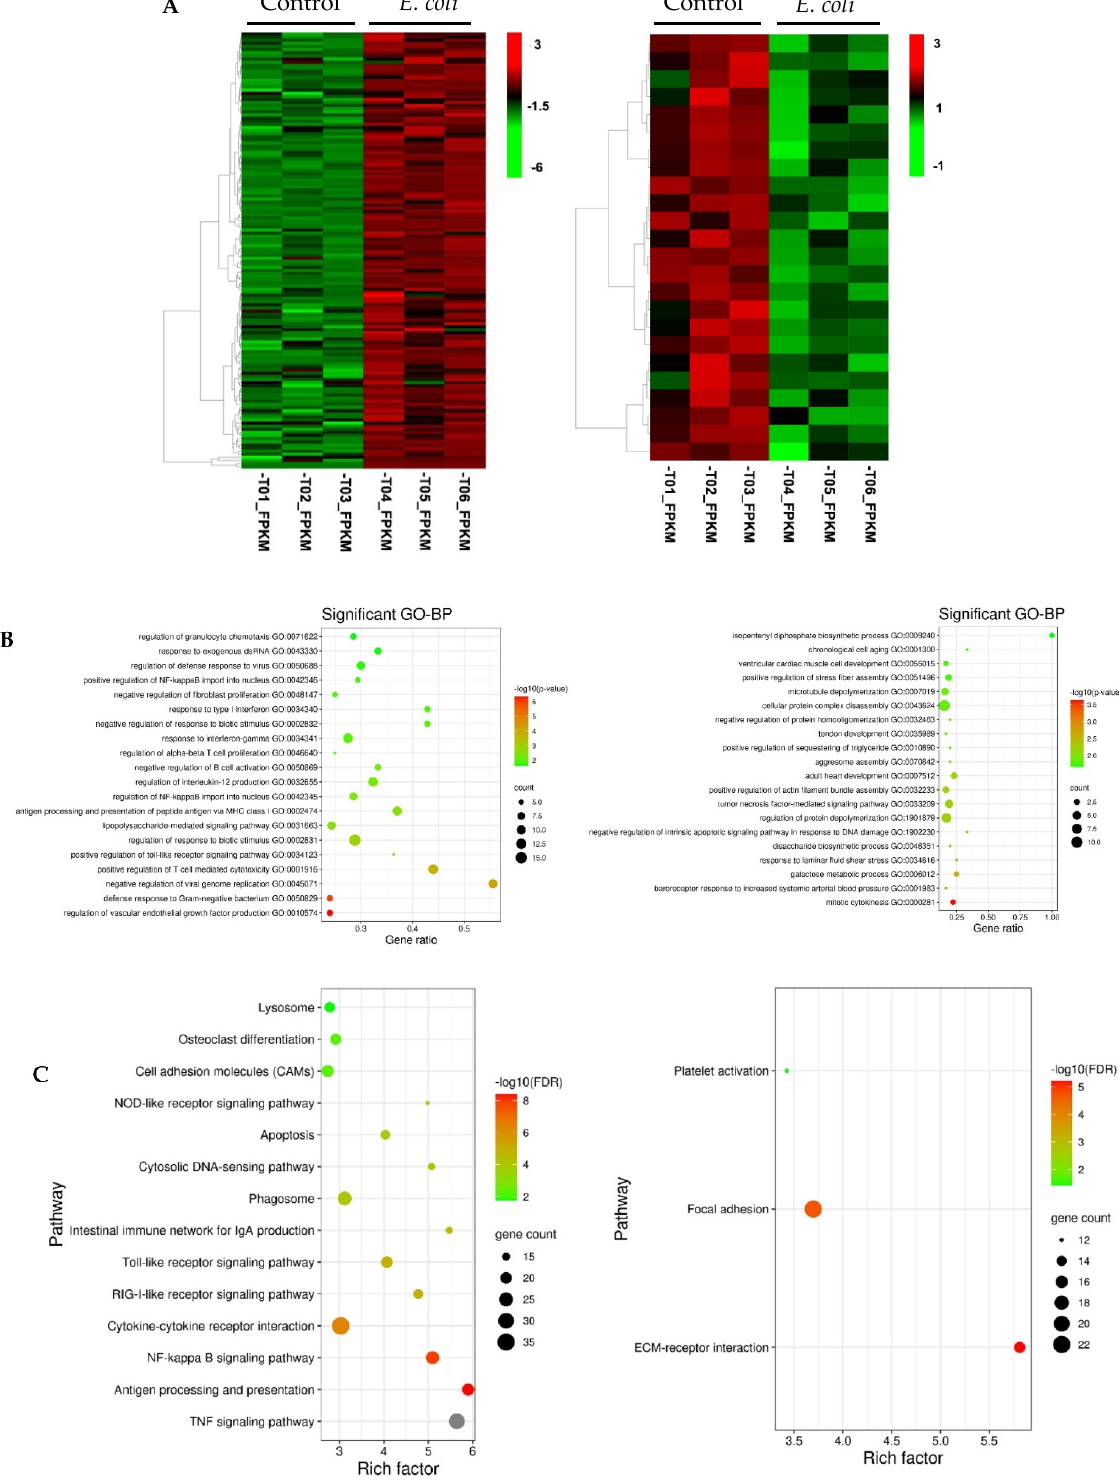
Figure 2. Function annotation and pathway analysis for the up- and downregulated genes between normal vs. E. coli samples. ( A ) Hierarchical clustering of gene expression for the up- (left panel) and downregulated (right panel) genes.